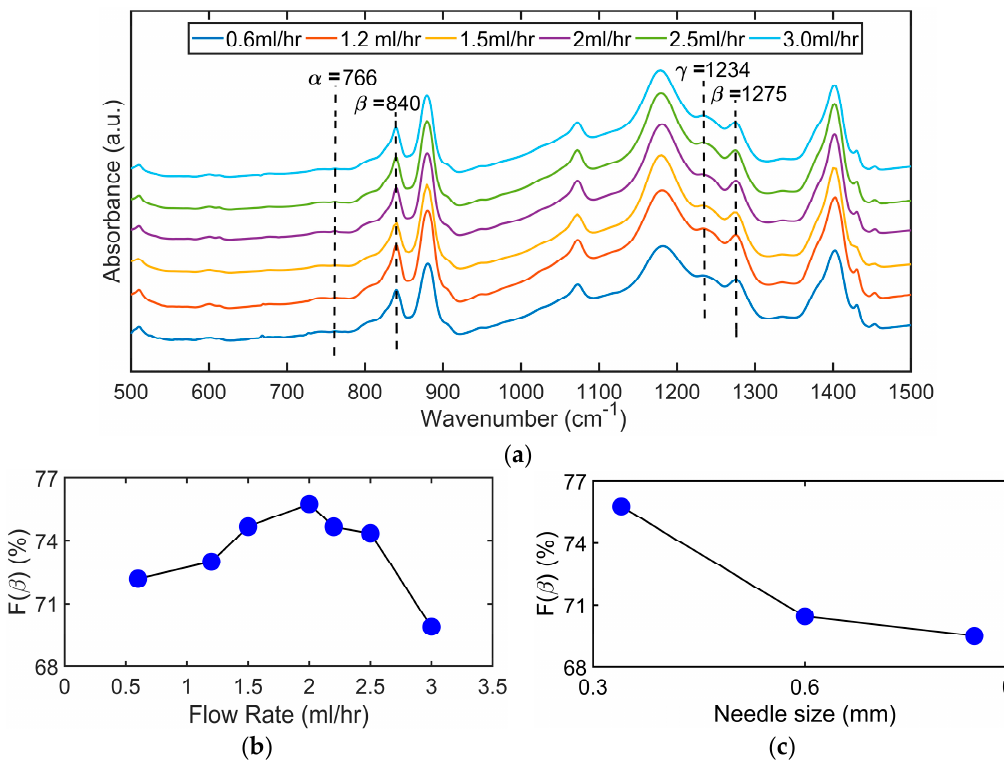
Figure 3. FTIR absorbance data of PVDF nanofibers prepared by electrospinning: ( a ) FTIR plot of absorbance for different flow rates. The peaks at 840 and 1275 cm − 1 denote the presence of β -phase in the sample; ( b ) Fraction of β -phase (in percentage) present in the sample against the flow rate; ( c ) Fraction of β -phase (in percentage) present in the sample against three different needle size.